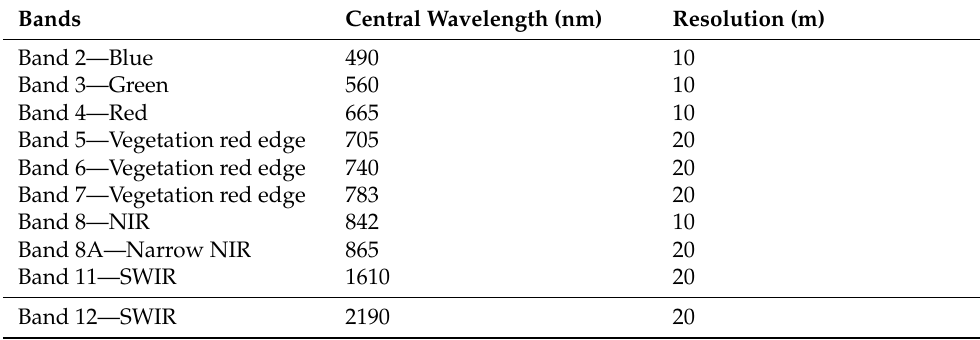
Table 1. Band specifications of Sentinel-2B product used in the study.